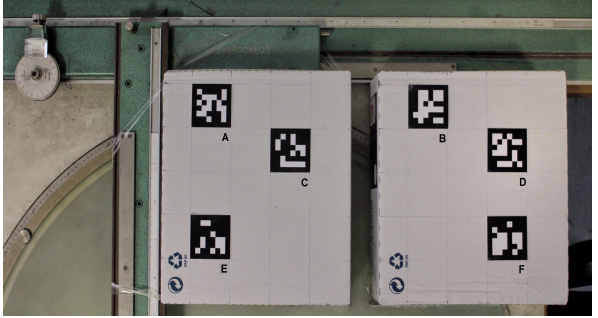
Figure 2. Simulation of the crack opening: the coordinatographer and the six ArUco markers.